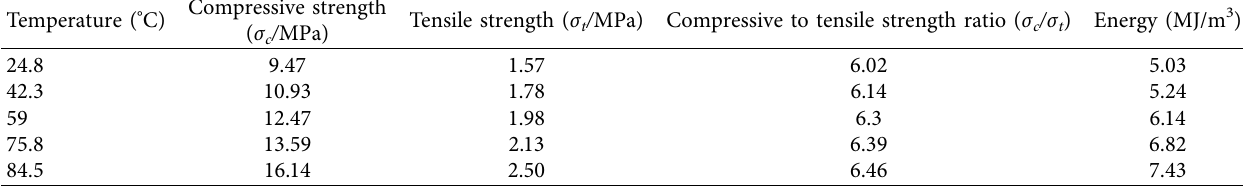
Table 13: Mechanical properties of similar materials at different temperatures covered by the study. Compressive strength Temperature ( ° C) ( σ c /